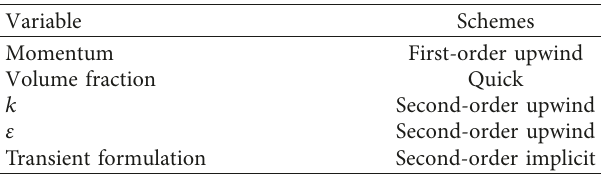
Figure 2: (a) The equipment drawing of investigated spray flu- idized bed extractor. (b) CFD grid. Table 2: Numerical schemes.